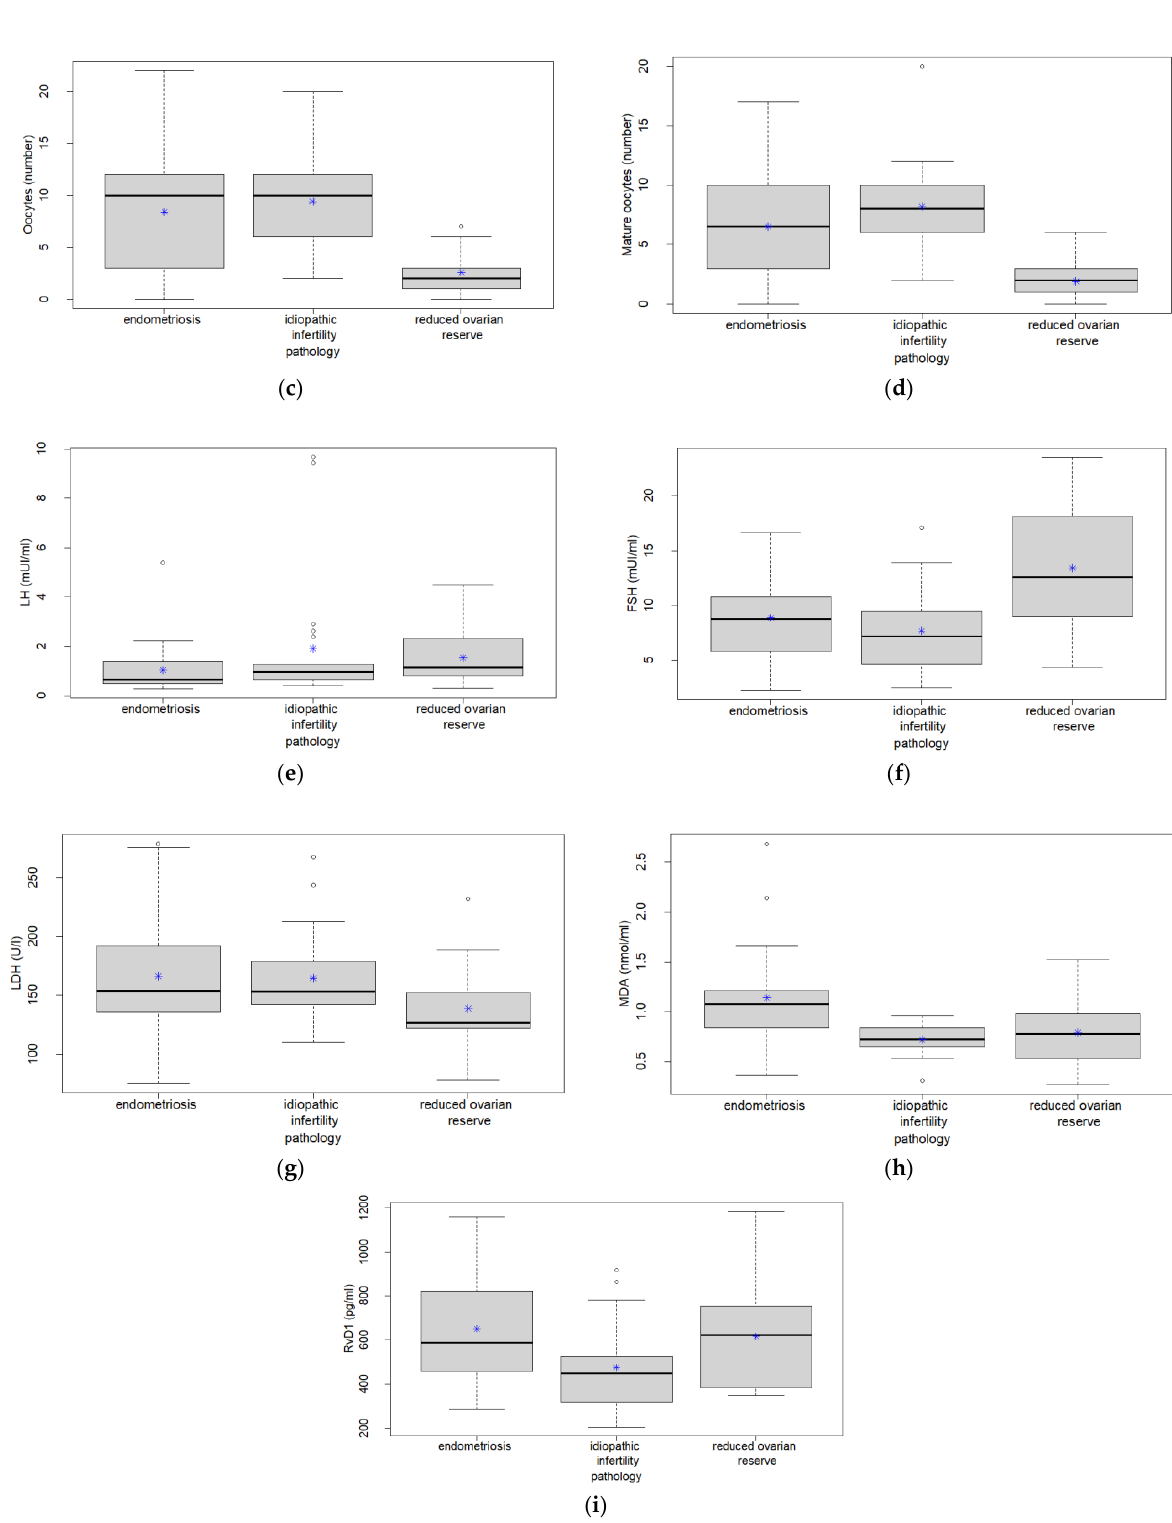
Figure 1. Box plots of the three groups (endometriosis, idiopathic infertility, and reduced ovarian reserve) for the variables: age ( a ), anti-Müllerian hormone (AMH, b ), number of oocytes ( c ), number of mature oocytes ( d ), luteinising hormone (LH, e ), follicle stimulating hormone (FSH, f ), lactate dehydrogenase (LDH, g ), malondialdehyde (MDA, h ), and resolvins (RvD1, i ) in terms of medians (bold lines), 25° and 75° centile (horizontal lines of the box), interquartile range (height of the box), spread outside 25° and 75° centile (dotted vertical lines), and outliers (dots). Stars denote mean values.